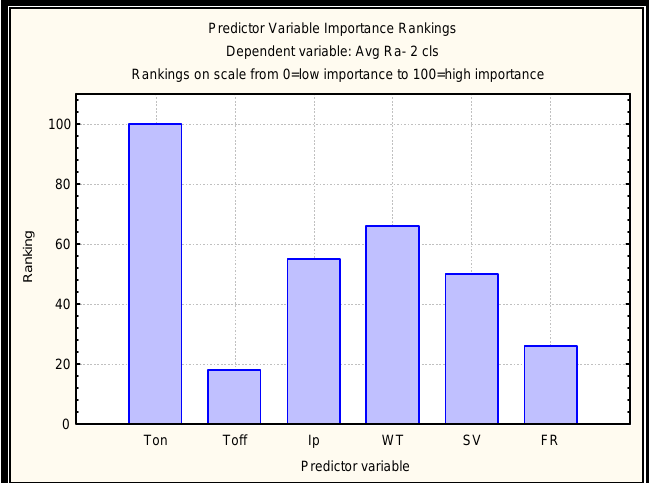
Fig. 9. Predictor variable importance ranking for Ra Classification Tree for Wire offset- 3 cls Number of splits = 7; Number of terminal nodes = 8